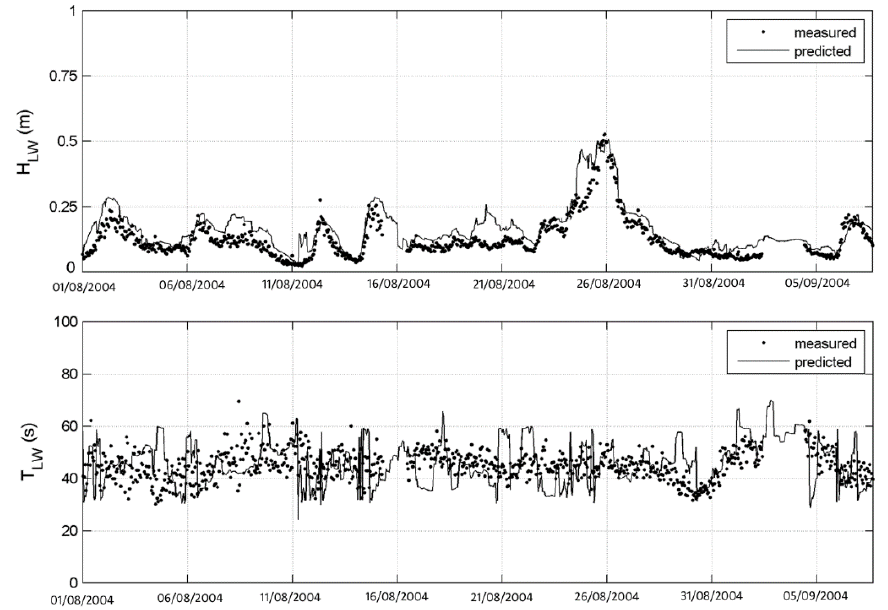
Figure 4. Comparison of long wave time series obtained for H LW and T LW , for the AWAC location, during August and September 2004. Predicted (line); measured (points).